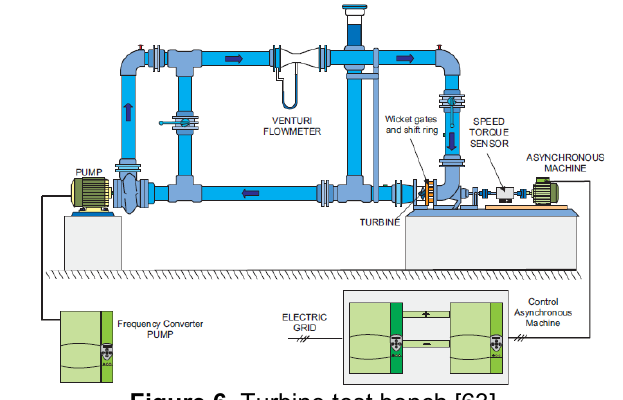
Table 6. Summary of applications of AI for feasibility